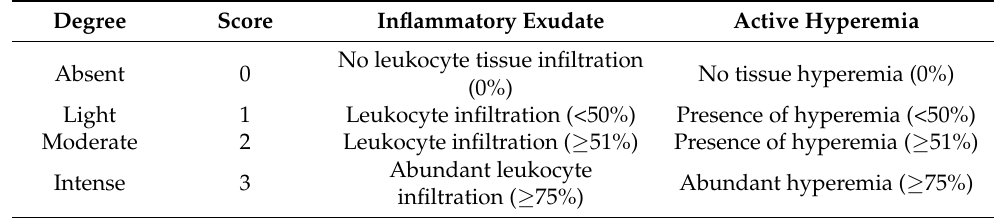
Table 2. Inflammatory score graduation scale [134].